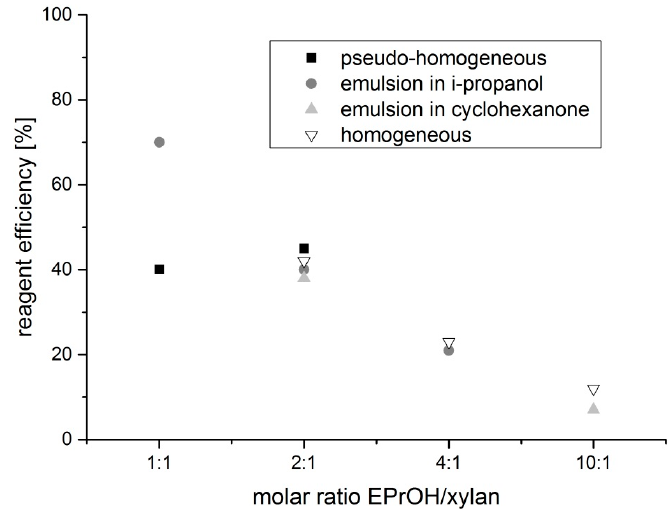
Figure 4. Reagent efficiency in dependence on the amount of epoxypropanol engaged for the various methods used.